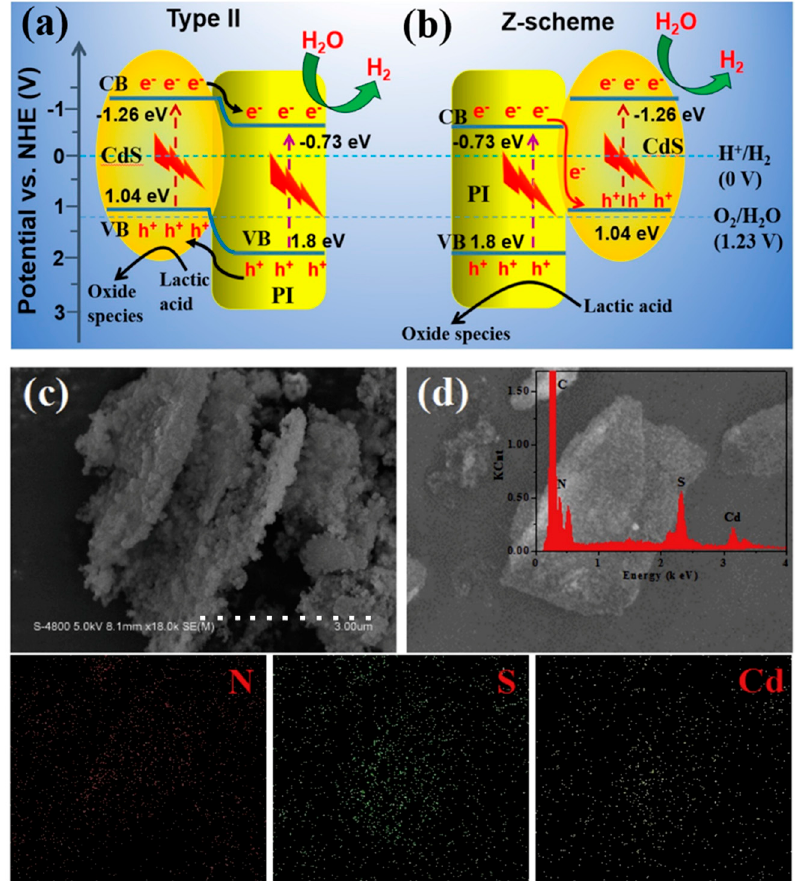
Figure 21. Schematic illustration of ( a ) traditional type ‐ II heterojunction and ( b ) direct Z ‐ scheme charge transfer mechanism: ( c ) 15% CdS/PI, ( d ) SEM–EDX image of 15% CdS/PI, and elemental mapping of the corresponding elements N, S, and Cd. Reprinted with permission from Ref. [194]. 2020, Elsevier.